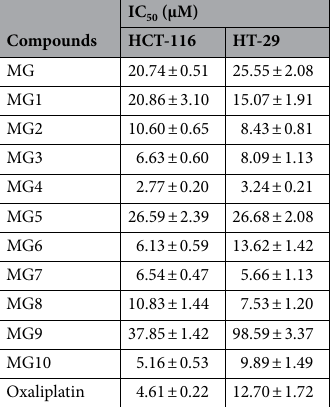
Table 1. IC 50 values of MG and its derivatives on HCT-116 and HT-29 cells.